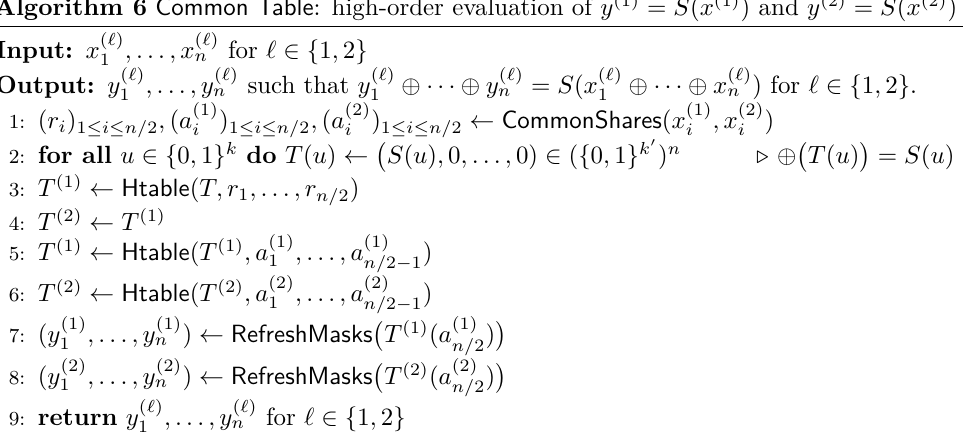
Algorithm 6 Common Table : high-order evaluation of y (1) = S ( x (1) ) and y (2) = S ( x (2)